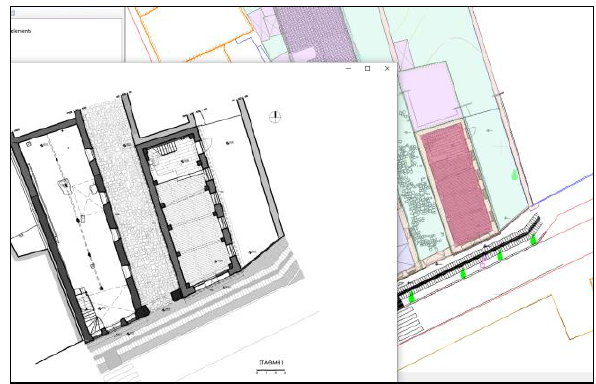
Figure 16 . The GIS application (linkage of features classes with plans).